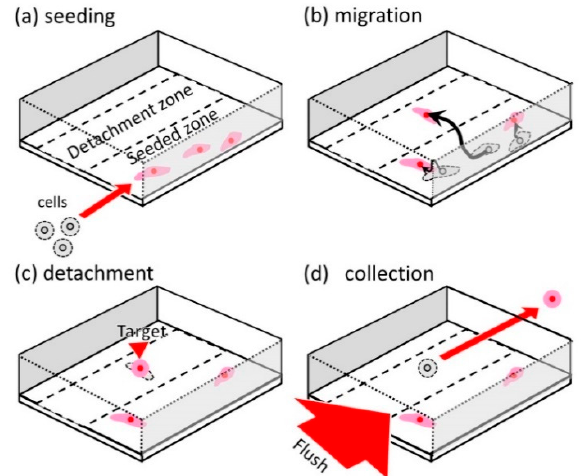
Figure 1. Collection of high-migratory cells. ( a ) Seeding of cells in a cell culture microchamber. ( b ) Cell migration in the cell culture microchamber. ( c ) Detachment of high-migratory cells. ( d ) Collection of the high-migratory cells.